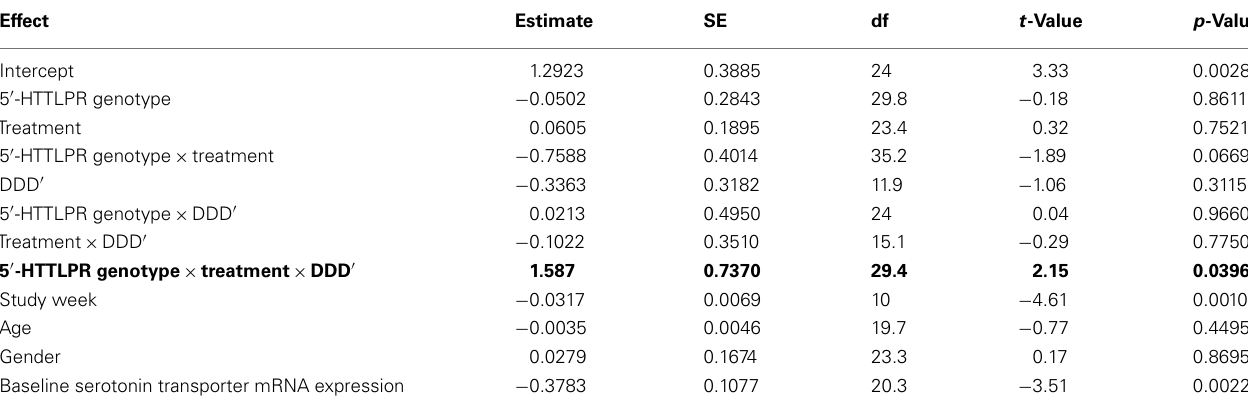
Table 2 | Effects of variables included in the mixed-effects linear regression model on serotonin mRNA expression